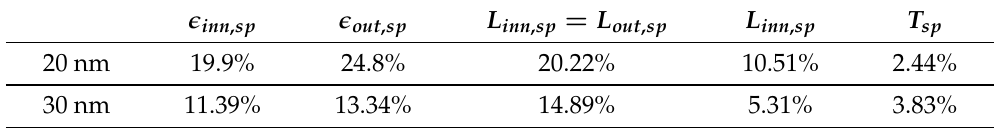
Table 4. Calculated percentage sensitivity values for oscillating frequency. (cid:101) inn , sp (cid:101) out , sp L inn , sp = L out , sp L inn , sp T sp 20